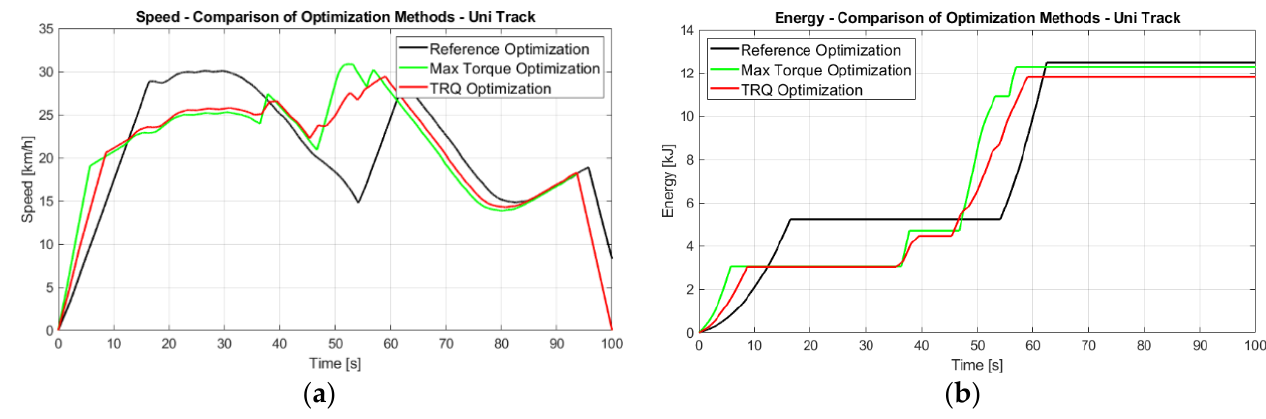
Figure 13. Track optimization results for Uni Track; ( a ) speed profile; ( b ) energy consumption.